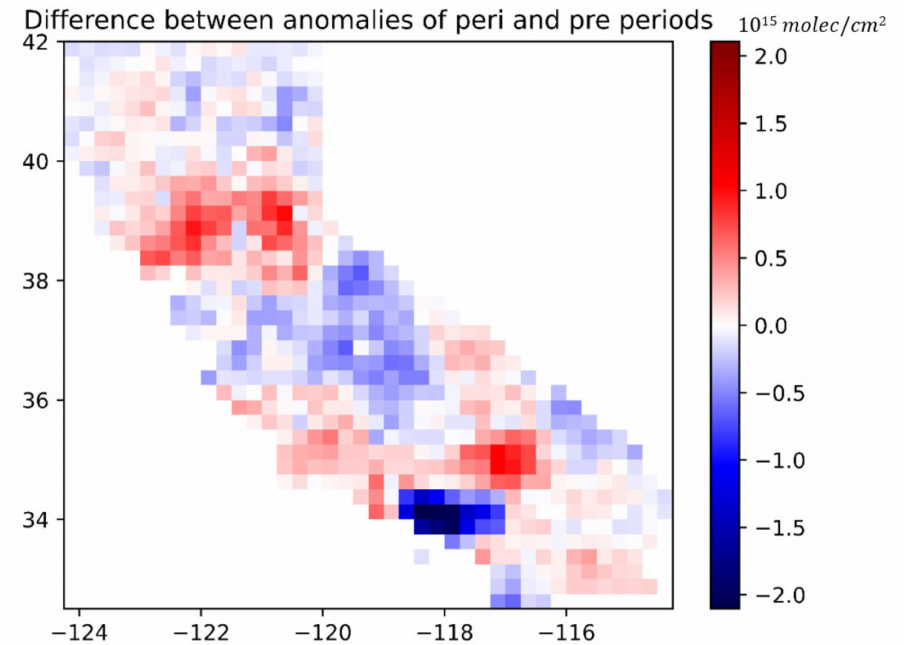
Figure 5. Spatial patterns of changed tropospheric NO 2 TVCD over CA (post-period of 2020 in comparison to peri-period of 2020). (Replicated from [53]).